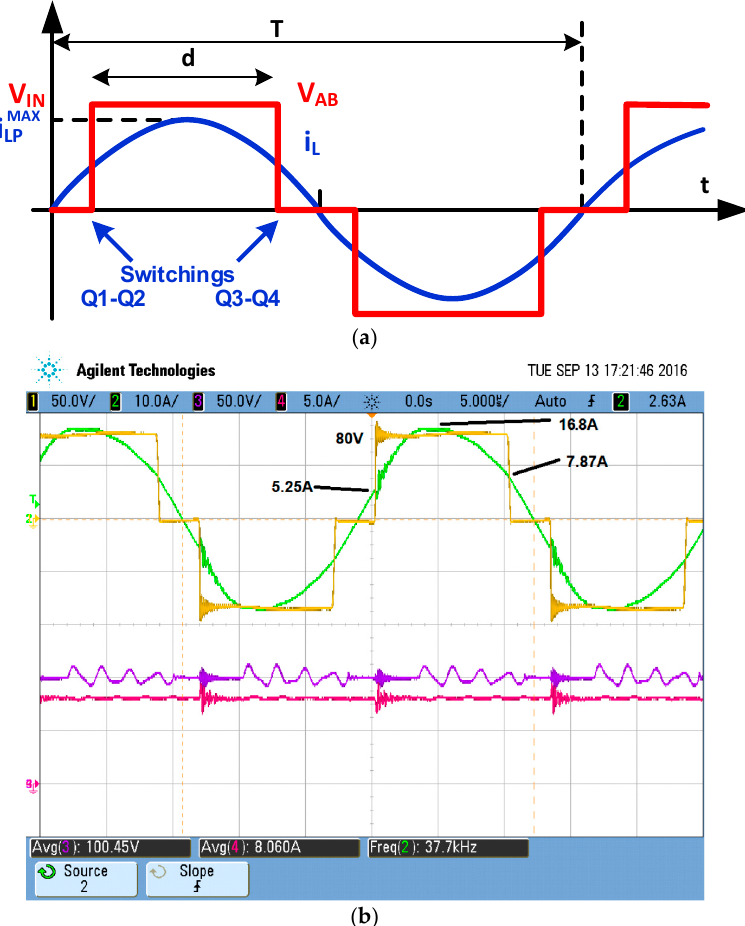
Figure 8. ( a ) Theoretical waveforms of V AB (red) and i PL (blue); ( b ) Experimental waveforms of V AB (yellow) and i PL (green) scaled to V IN = 80 V, V O = 100 V and P O = 800 W.